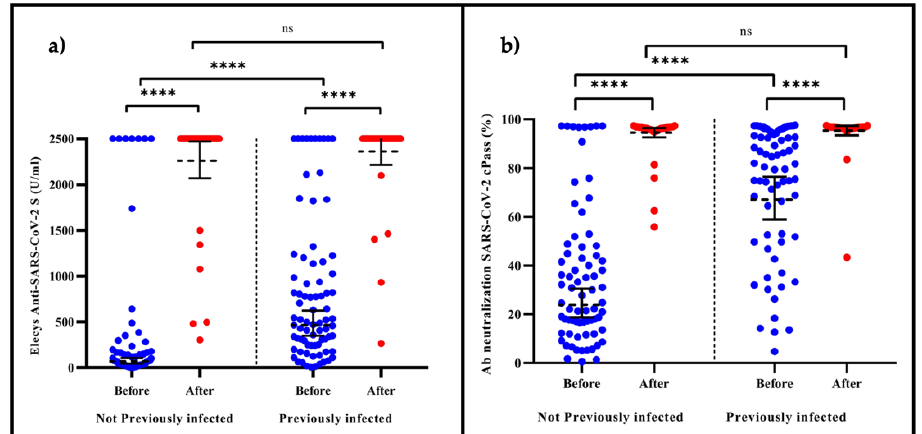
Figure 1. ( a ) The effect at 21 days of the heterologous booster with BNT162b2 evaluated with Elecsys ®